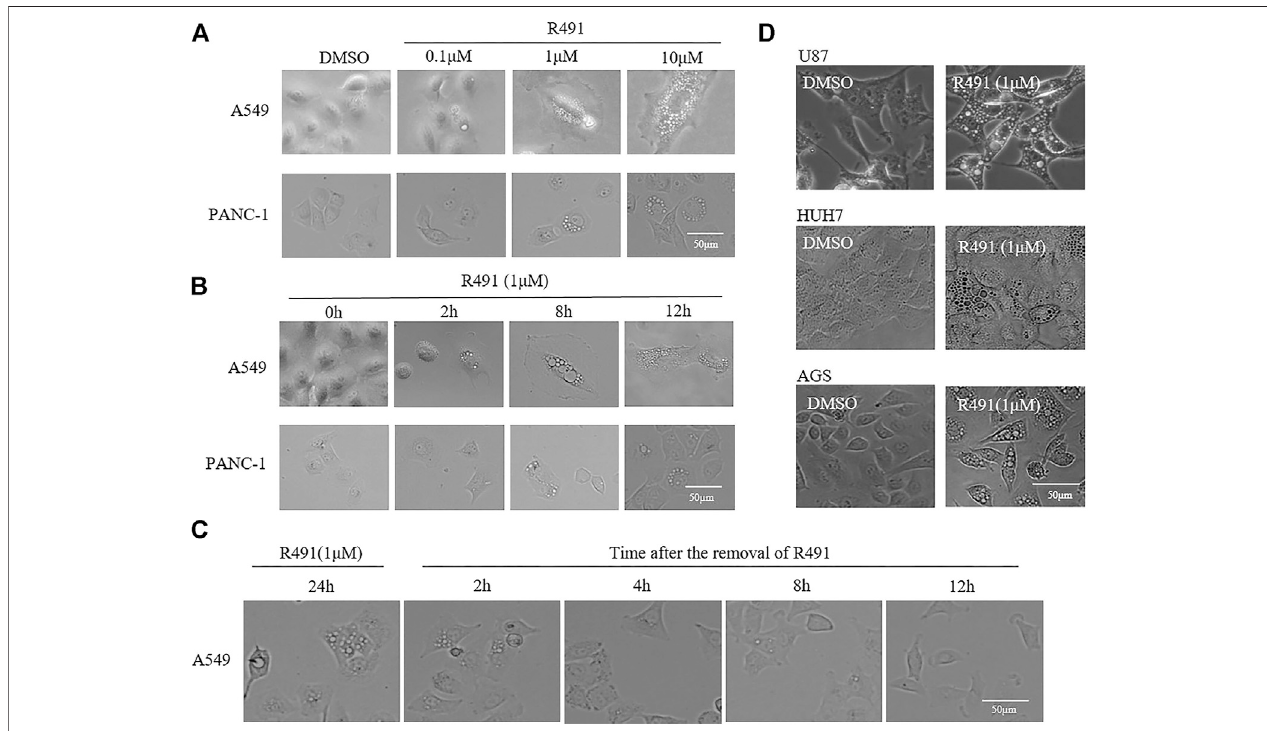
FIGURE 1 | The vimentin-binding compound R491 induced a rapid, strong and, reversible intracellular vacuolization in multiple types of cancer cells. (A) Morphological changes of A549 and PANC-1 cells treated with R491 at different concentrations of for 72 h. (B) Morphological changes of A549 and PANC-1 cells treated with R491 at 1 µM for different lengths of time. (C) Morphology of A549 cells treated with R491 at 1 µM for 24 h, and at different time after the removal of R491 from the culture. (D) Morphological changes of U87, HUH7, and AGS cells treated with 1 µM R491 for 72 h. Scale bars: 50